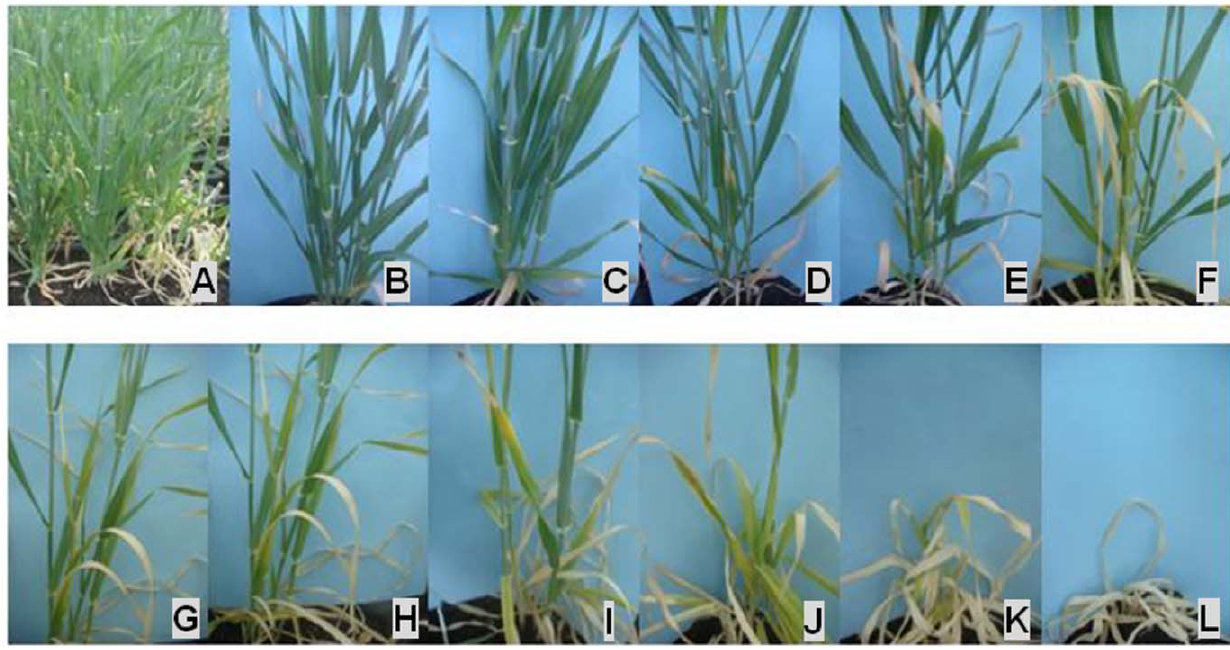
Figure 1. Range of phenotypes induced by salt stress at the booting stage in potting mixture experiment. A: part of the whole trial showing tolerant (left and middle) and susceptible lines (right) in the same trial; B to L: lines with scores of 0 (very tolerant) to 10 (very sensitive – all dead), respectively. doi:10.1371/journal.pone.0043079.g001 wide permutation tests implemented in MapQTL version 5.0 support intervals around each QTL were established, by taking the two positions, left and right of the peak, that had LOD values of trait, resulting in a 95% LOD threshold around 3.1. Two LOD two less than the maximum [34], after performing restricted